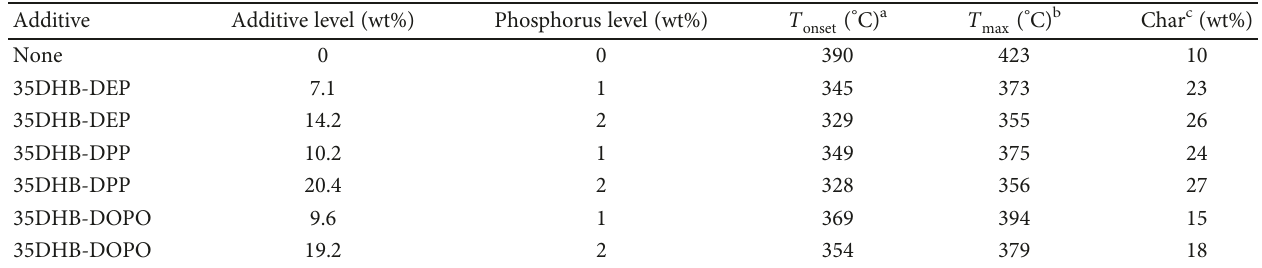
Table 7: Thermal degradation characteristics for blends of phosphorus esters of methyl 3,5-dihydroxybenzoate in DGEBA epoxy resin. Additive Additive level (wt%) Phosphorus level (wt%)